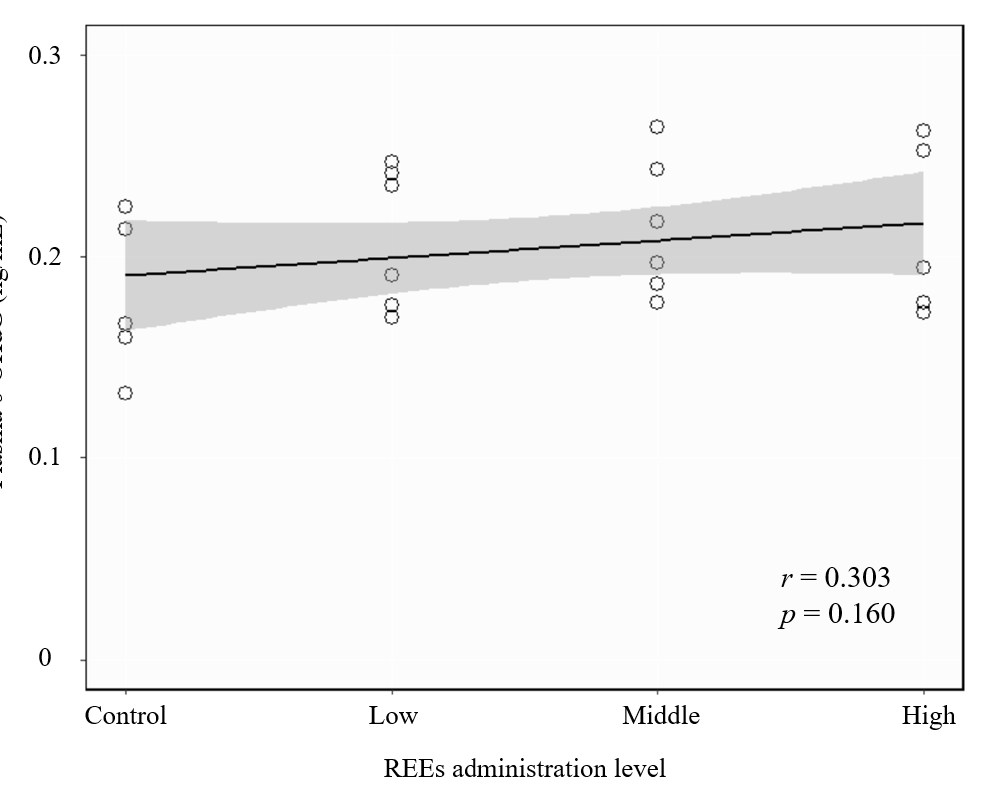
Figure 3. Spearman correlation between the administration dose level of REEs to rats and 8-OHdG concentration in rat plasma. The dose–response curve is fitted by using linear regression model with R software. The shaded area represents the 95% confidence level.